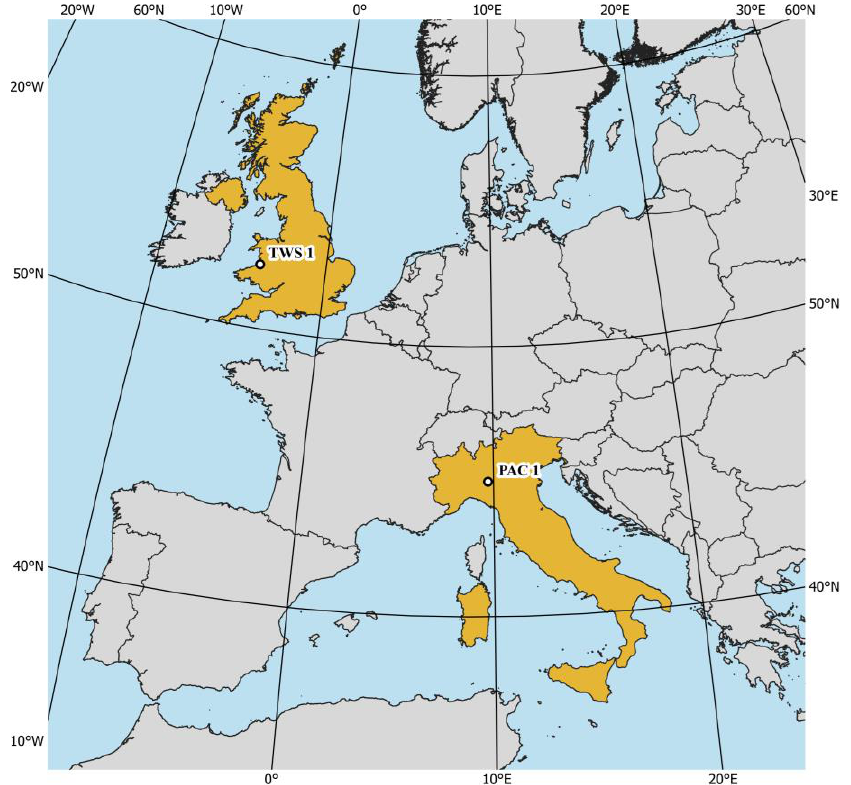
Figure 1. Field experiment locations: PAC 1 is situated in Piacenza (North-West Italy) and TWS in Aberystwyth (Mid-West Wales).